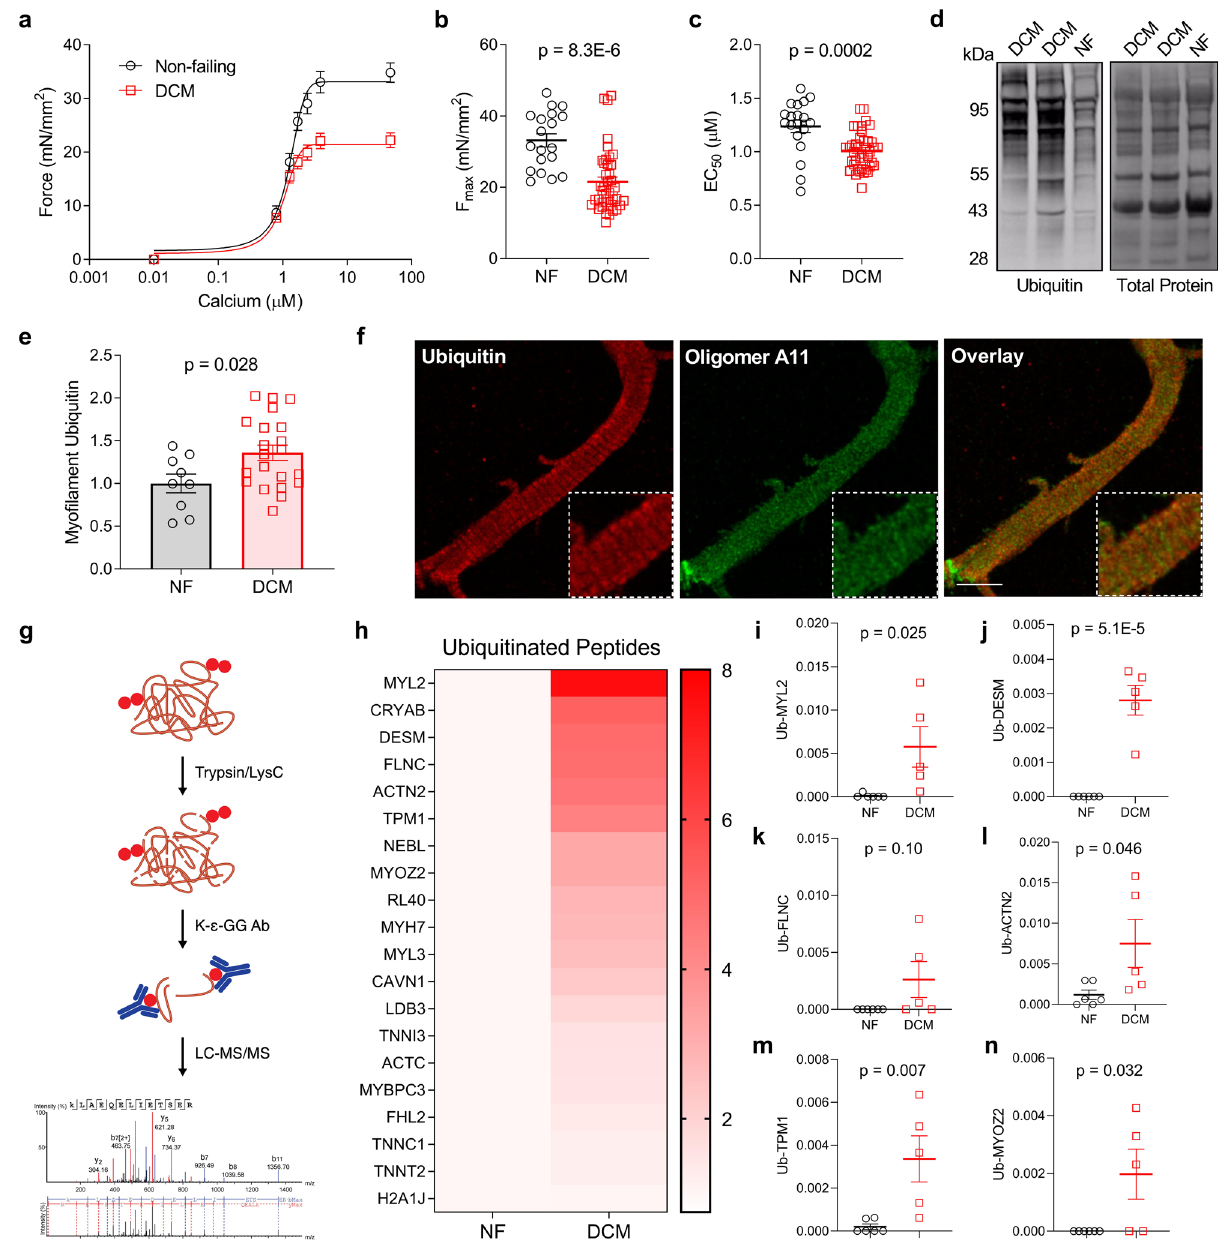
Fig. 1 Human DCM is characterized by decreased myo fi lament function and impaired sarcomere protein turnover. a Skinned myocyte force-calcium relationship from human nonfailing (NF) and dilated cardiomyopathy (DCM) cardiomyocytes; n = 19 NF from 6 patients, 41 DCM from 12 patients. b, c Summary data for myocyte F max ( b ) and EC 50 ( c ) corresponding to the force-calcium graph in a . d Western blot for ubiquitin in the NF and DCM left ventricle (LV) myo fi lament fraction; image is representative of 9 NF samples and 21 DCM samples. e Ubiquitin signal normalized to total protein; n = 9 NF, 21 DCM. f Immuno fl uorescence image of a human LV cardiomyocyte immunostained for ubiquitin and oligomer A11; ×63 magni fi cation, scale bar = 10 µ m; image is representative of the 16 images acquired. g Proteomics paradigm for ubiquitinated peptide enrichment. h Heatmap of the top 20 ubiquitinated proteins identi fi ed by LC-MS/MS for NF and DCM human patients normalized to total peptide input; scale bar = fold change increase relative to NF, darkest red color denoting greatest fold change. i – n Spectral count data for ubiquitinated peptides normalized to total peptide input for myosin regulatory light chain ( i ), desmin ( j ), fi lamin-C ( k ), α -actinin ( l ), tropomyosin ( m ), and myozenin-2 ( n ); n = 6 NF, 5 DCM. All data are presented as mean ± SEM and were analyzed by two-tailed t-